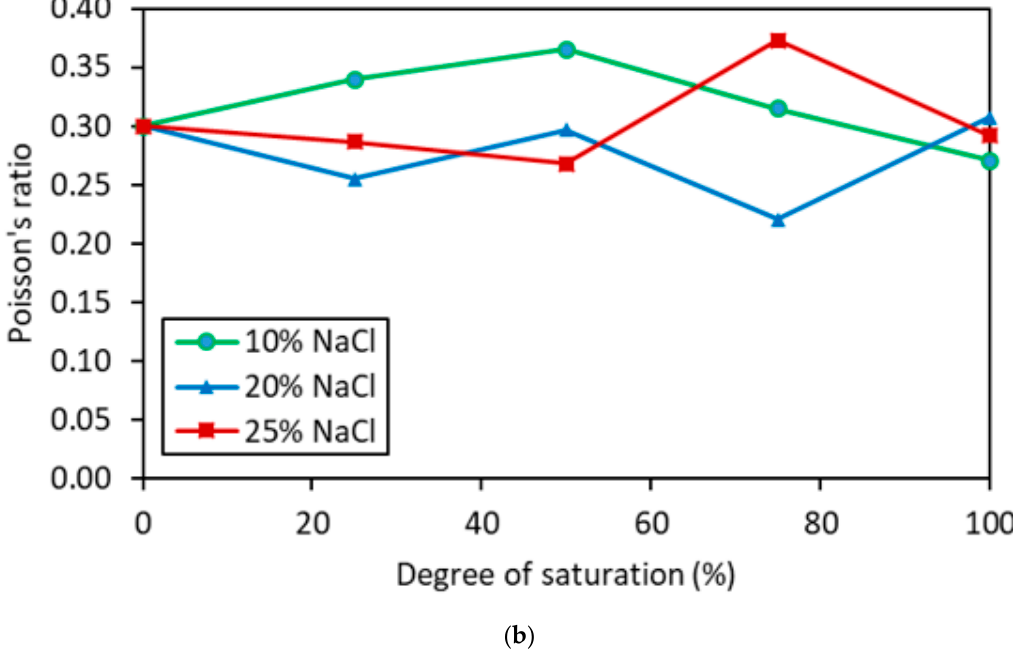
Figure 11. Variation of ( a ) Yong’s modulus and ( b ) Poisson’s ratio of siltstone in 10%, 20%, and 25% NaCl.